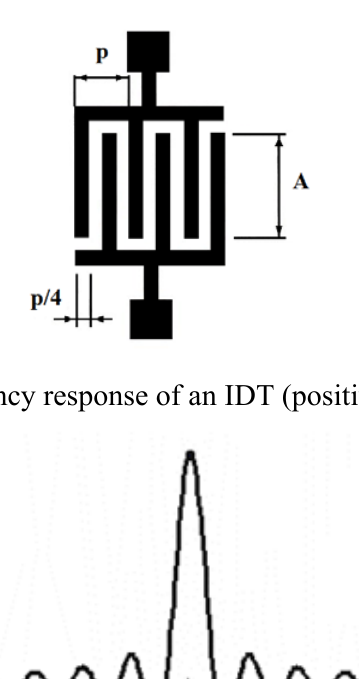
Figure 2. Interdigital Transducer (IDT) with period p , electrode width equal to space between electrodes and aperture A.